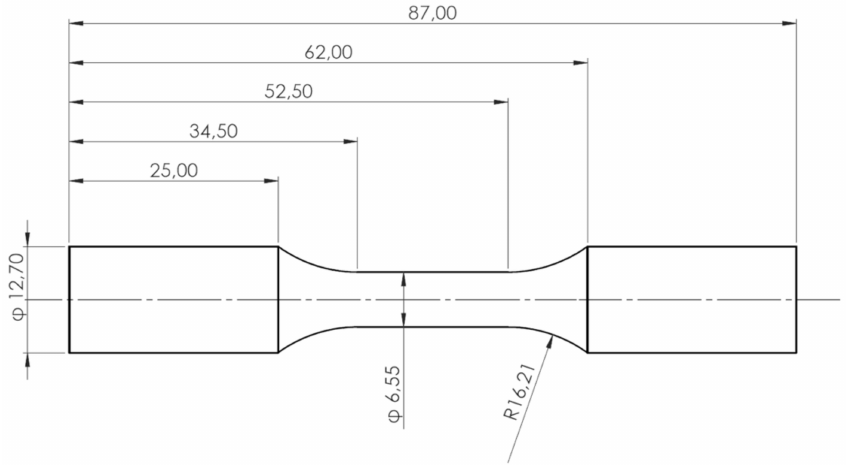
Figure 4. Geometry of the test bars prepared in agreement with ASTM standards [All dimensions are in